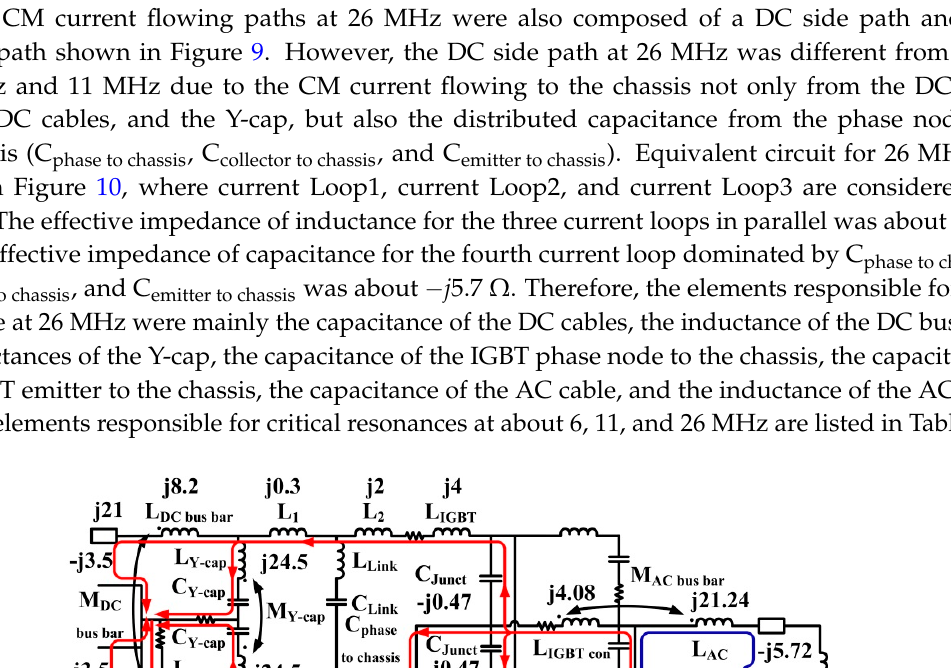
Figure 9. Current ‐ following path at 26 MHz.